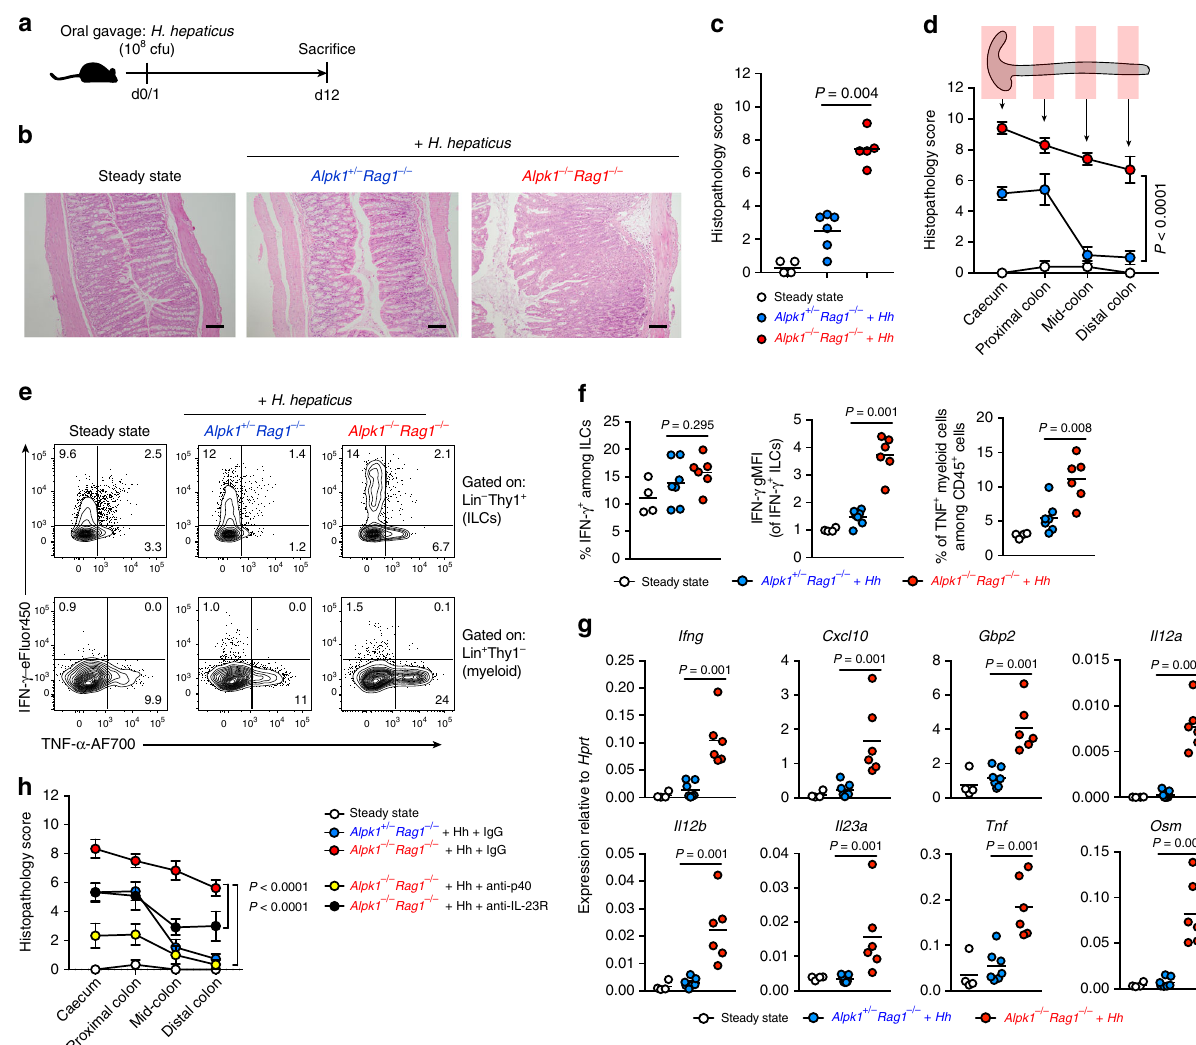
Fig. 2 Alpk1-de fi cient mice are highly susceptible to Hh -induced innate colitis. a Experimental schematic of Hh infection using B6. Rag1 − / − Alpk1 − / − mice or B6. Rag1 − / − Alpk1 + / – littermate controls. b Representative H&E stained mid-colon cross-sections at steady state and after 12 days of Hh infection.